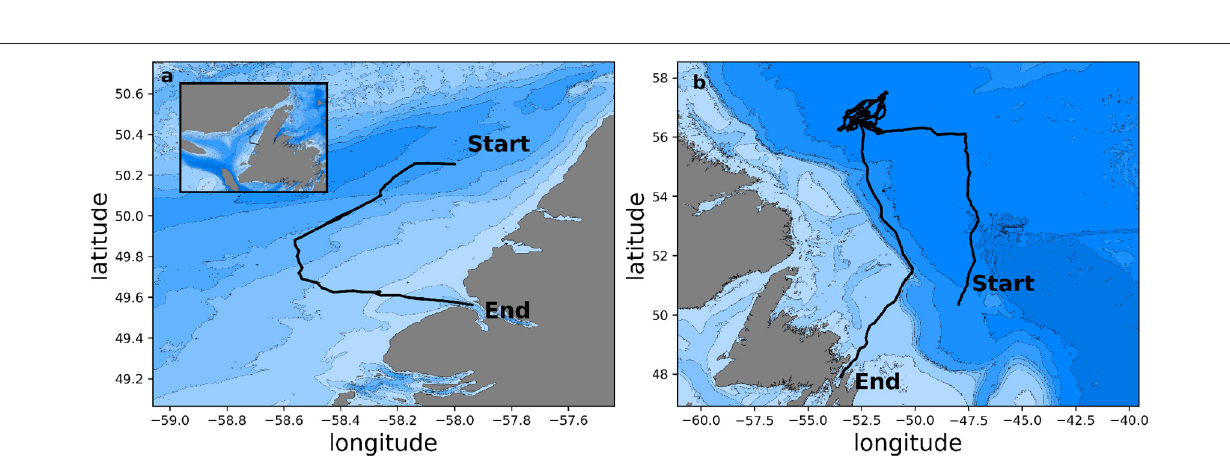
FIGURE 6 | Field Test Cases for OceanGNS. (a) One-week deployment of a glider in the Northern Gulf of St. Lawrence (August 8–15, 2019) from Daniels Harbor to Bonne Bay. (b) Seven-month glider deployment in the Labrador Sea (December 4, 2019 - June 27, 2020). GEBCO bathymetry is shown in the